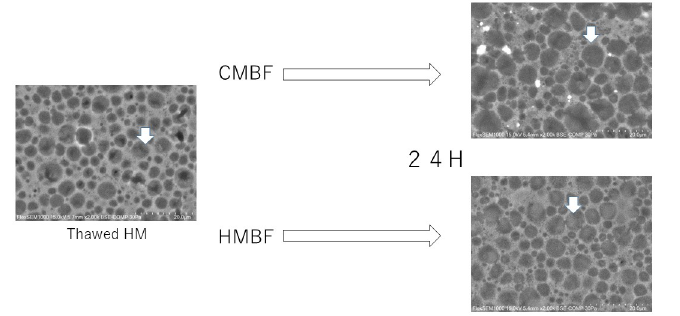
Fig 4. MFG with electron microscope. The electron microscopes for unfortified human milk (left side) and the fortified human milk at 24 hours after fortification are shown (right side; the upper photo indicates CMBF and the lower photo indicates HMBF). The arrow indicates MFGs.